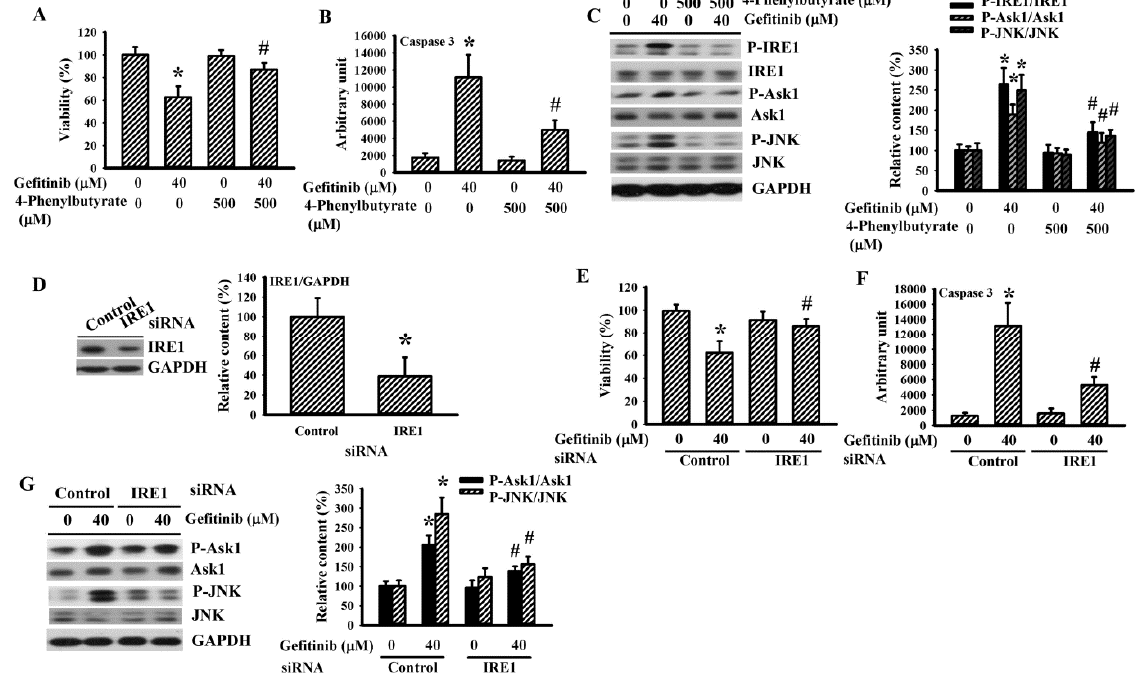
Figure 3. 4-Phenylbutyrate and Inositol-Requiring Enzyme 1 (IRE1) silencing alleviated gefitinib-induced apoptosis in H4 cells. H4 cells were treated with gefitinib (0 and 40 µ M) together, with or without 4-phenylbutyrate (500 µ M, A – C ). Cell viability (24 h) was measured with the alamarBlue assay ( A ). Caspase 3 activity (6 h) was measured with enzymatic assay ( B ). Protein extracts (6 h) were subjected to Western blot with indicated antibodies. Representative blots of three independent experiments and quantitative data are shown ( C ). H4 cells were transfected with control siRNA (1 nM) or IRE1 siRNA (1 nM) for 24 h. Protein extracts were subjected to Western blot with indicated antibodies. Representative blots of three independent experiments and quantitative data are shown ( D ). The transfected cells were then treated with gefitinib (0 and 40 µ M). Cell viability (24 h) was measured with the alamarBlue assay ( E ). Caspase 3 activity (6 h) was measured with enzymatic assay ( F ). Protein extracts (6 h) were subjected to Western blot with indicated antibodies. Representative blots of three independent experiments and quantitative data are shown ( G ). Protein contents were normalized with corresponding total protein or GAPDH. * p < 0.05 vs. untreated control and # p < 0.05 vs. gefitinib (40 μM), n = 4 ( A , B , E , F ).